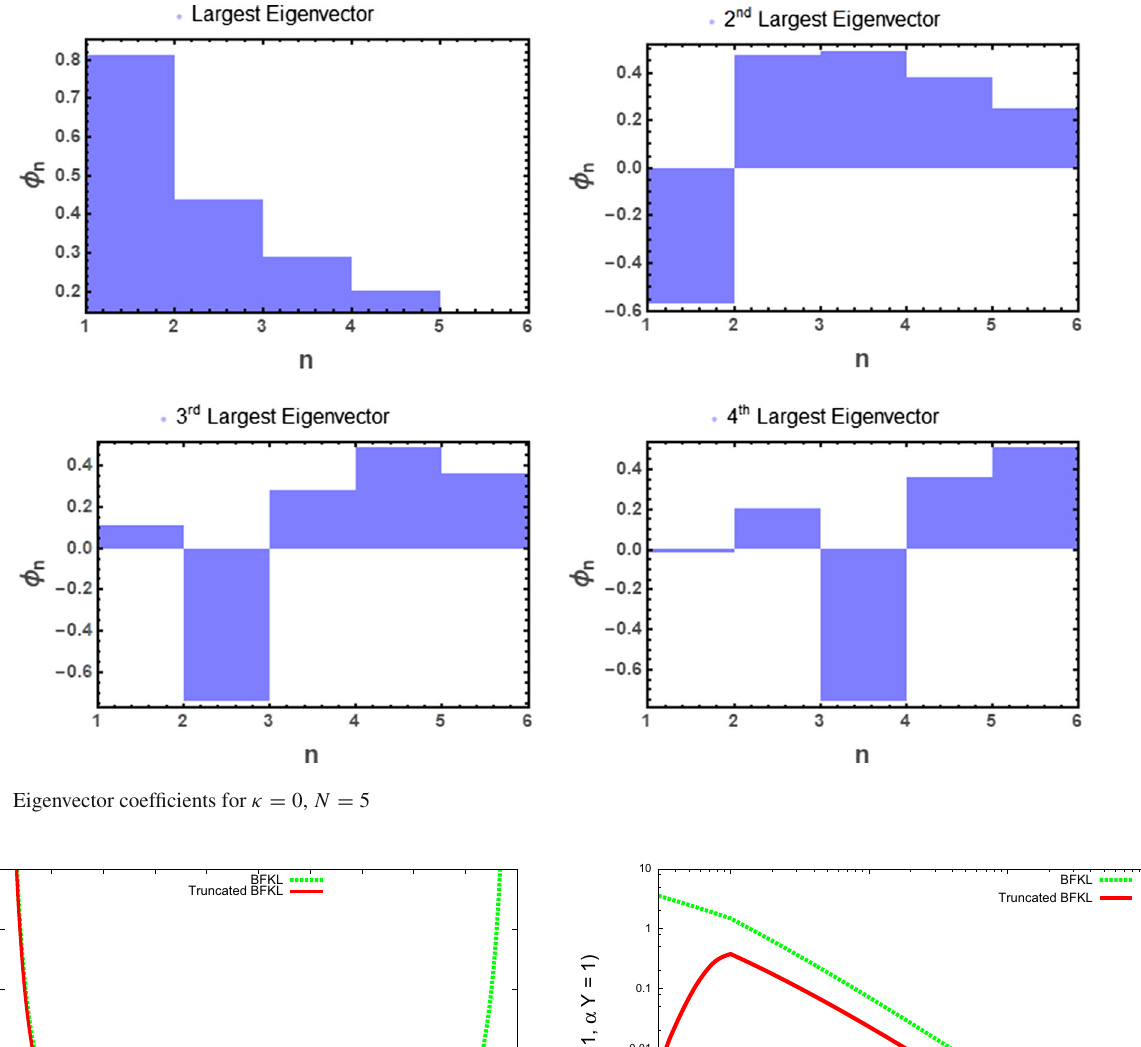
Fig. 15 Eigenvector coefficients for κ = 0, N = 5